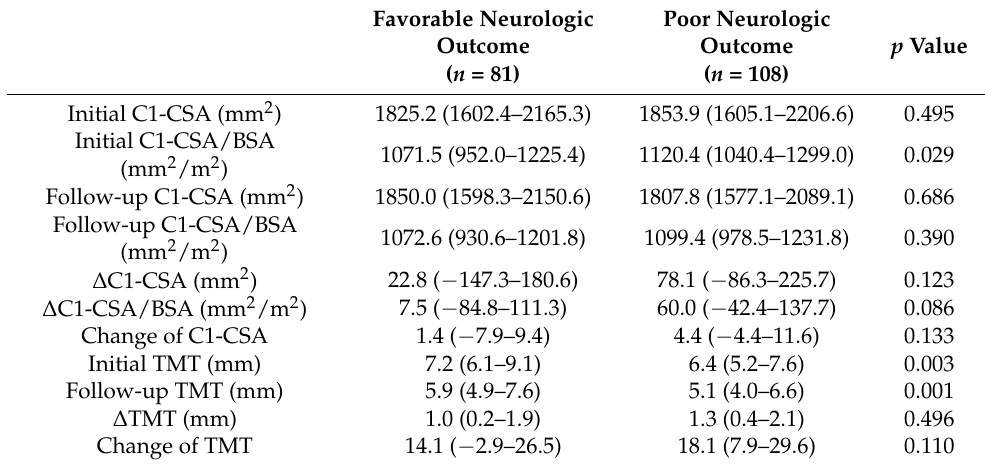
Table 2. The cross-sectional areas (CSAs) of first cervical vertebra level (C1) and temporalis muscle thicknesses (TMTs) according to neurological outcomes.